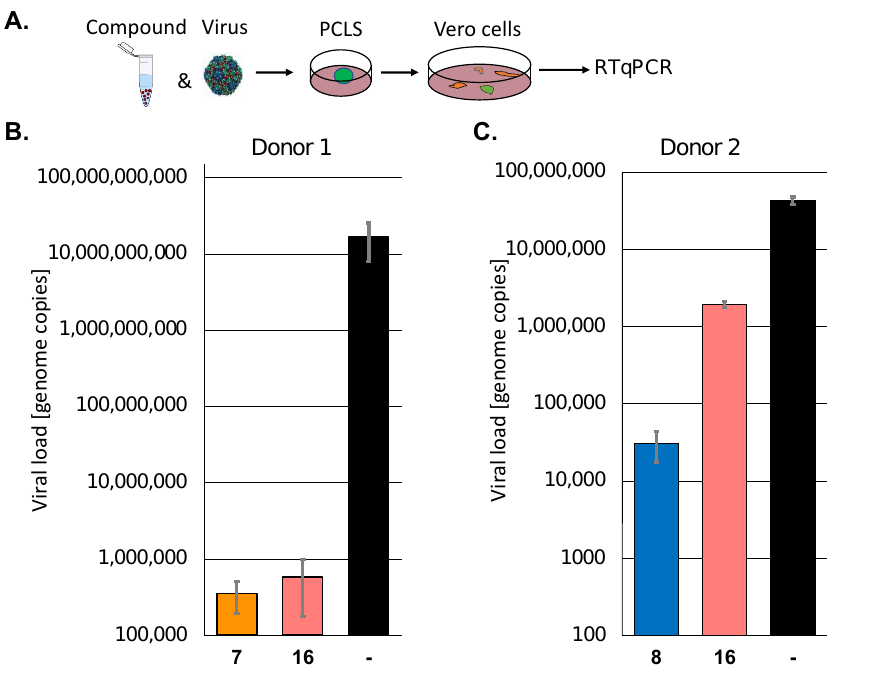
Figure 2. The protease inhibitors block SARS-CoV-2 replication in human PCLS of two different donors. ( A ) Scheme of the experimental setup. ( B , C ) Human PCLS were incubated with 30 µM of selected protease inhibitors and infected with SARS-CoV-2. All infections were performed in triplicates. Viral infectivity was determined by infecting Vero cells in duplicates with the supernatants. Viral loads were determined by RT-qPCR.